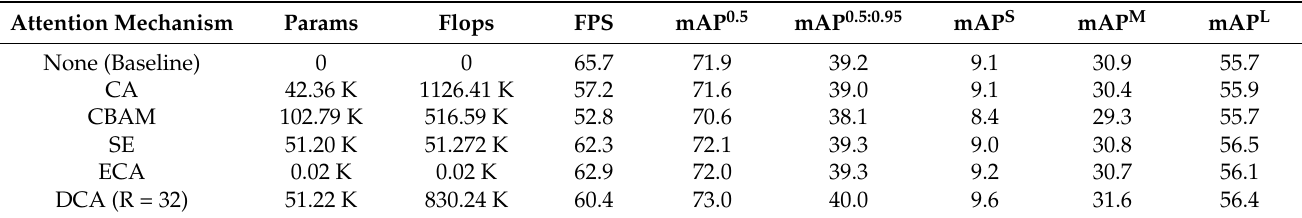
Table 8. Results of comparative experiment for different attention mechanisms.